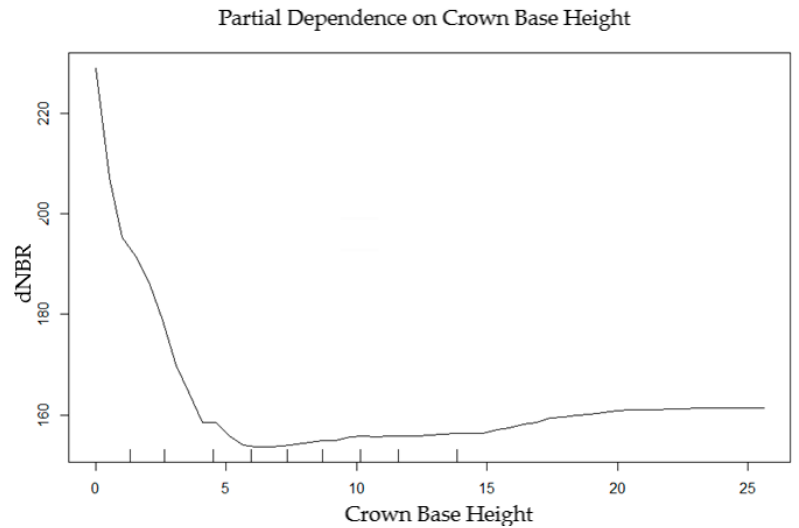
Figure 8. High-severity fire is followed by lower crown base heights. This is related to the low mean canopy height after high severity.